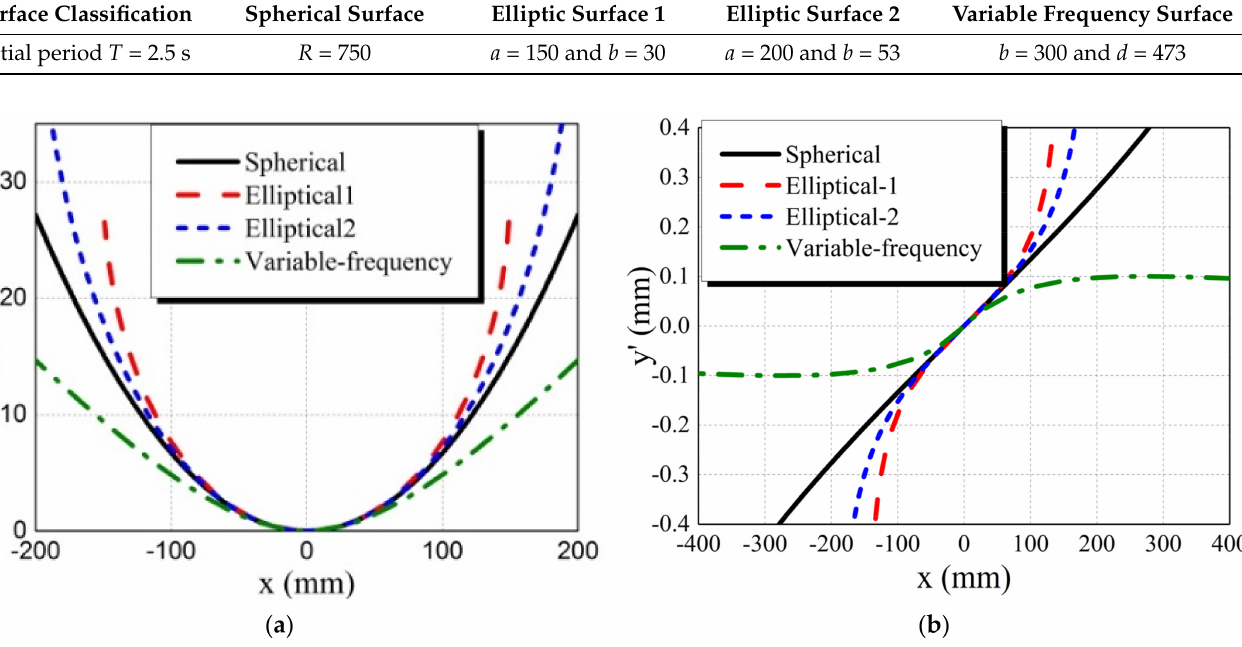
Table 1. The key parameters of four pendulum bearings (Unit: mm).